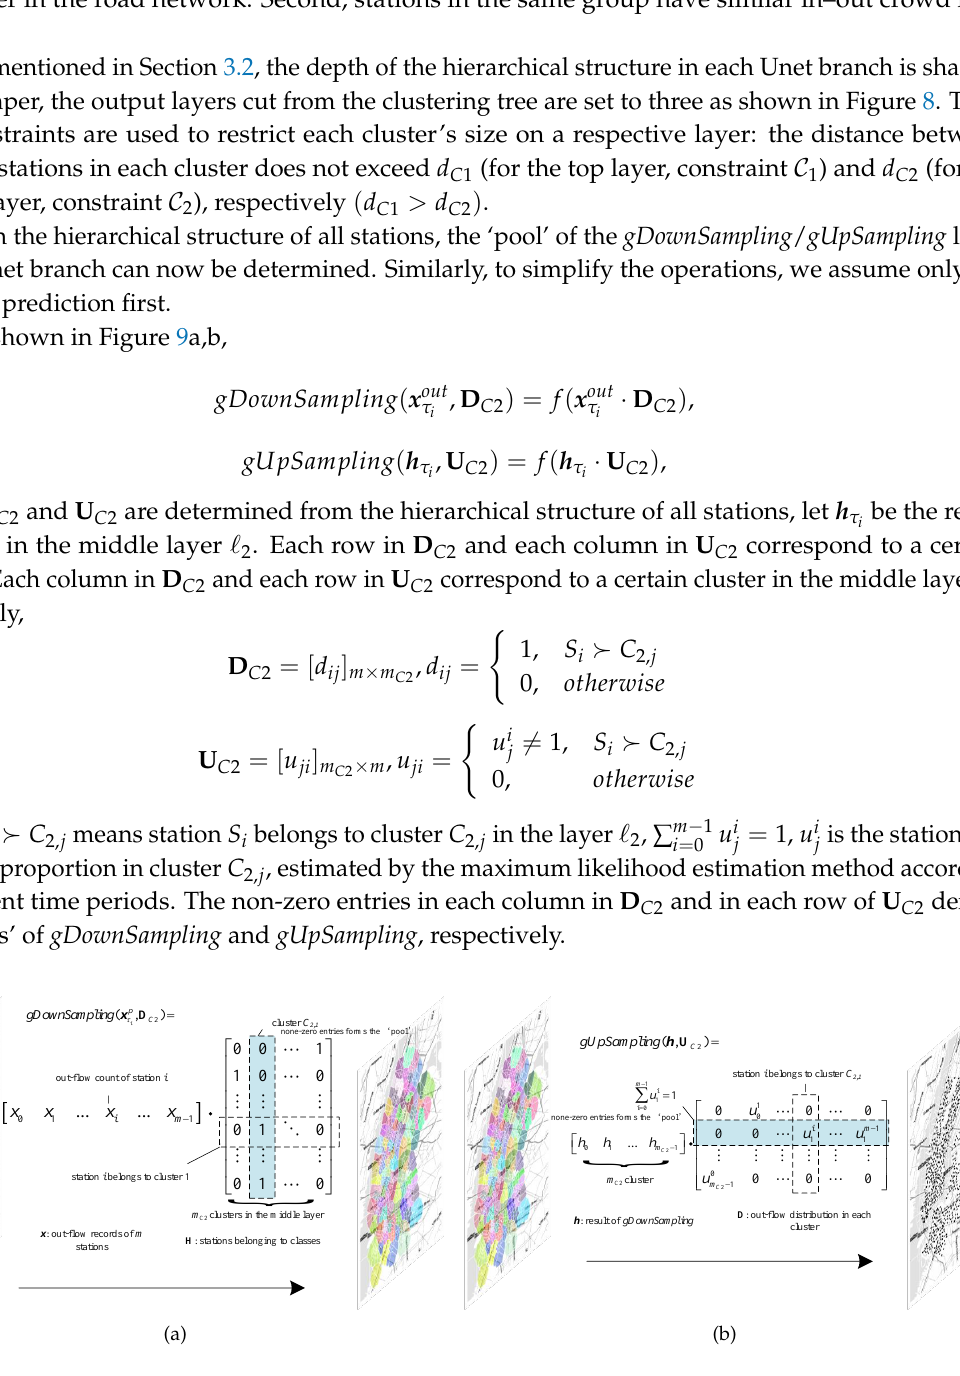
Figure 9. ( a ) gDownSampling; ( b ) gUpSampling